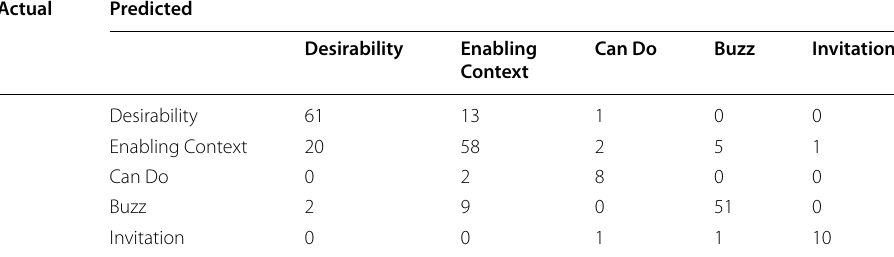
Table 11 Confusion matrix BERTweet embedding extraction scenario EE#3 Actual